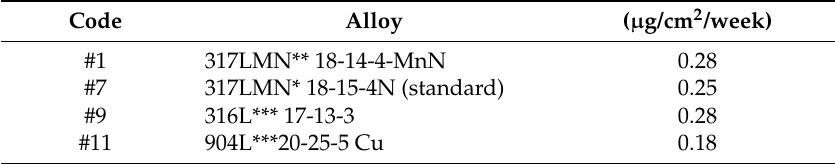
Table 10. Results of ICP analysis of the artificial sweat. Average of three measurements, ( µ g/cm 2 /week).